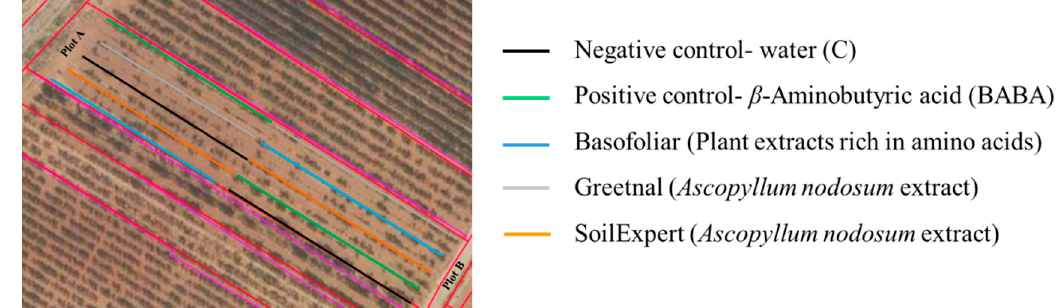
Figure 10. Experimental design of foliar applications in the vineyard.